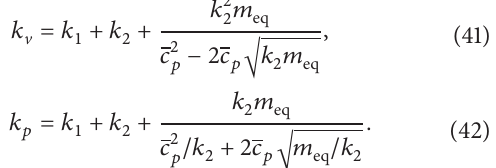
diameter. The dotted line in Figure 9(b) represents the numerical simulation results of the equivalent damping when = 10 𝑑 𝑝